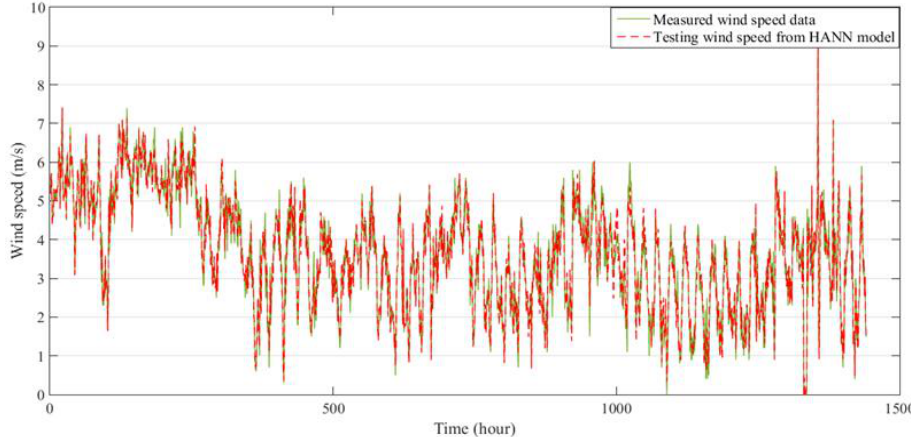
Figure 11. Comparison between measured and predicted wind speed for two months at Mersing in 2015, for validation of the HANN model.